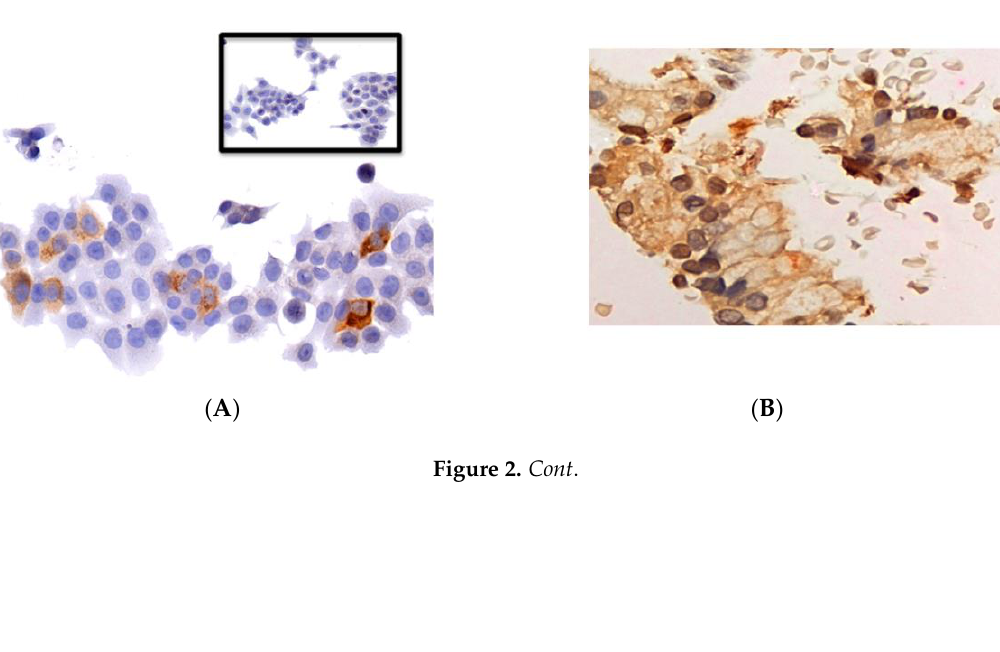
Table 2. Most commonly identified toxicities for pelareorep in combination with gemcitabine. (>10% of patients).